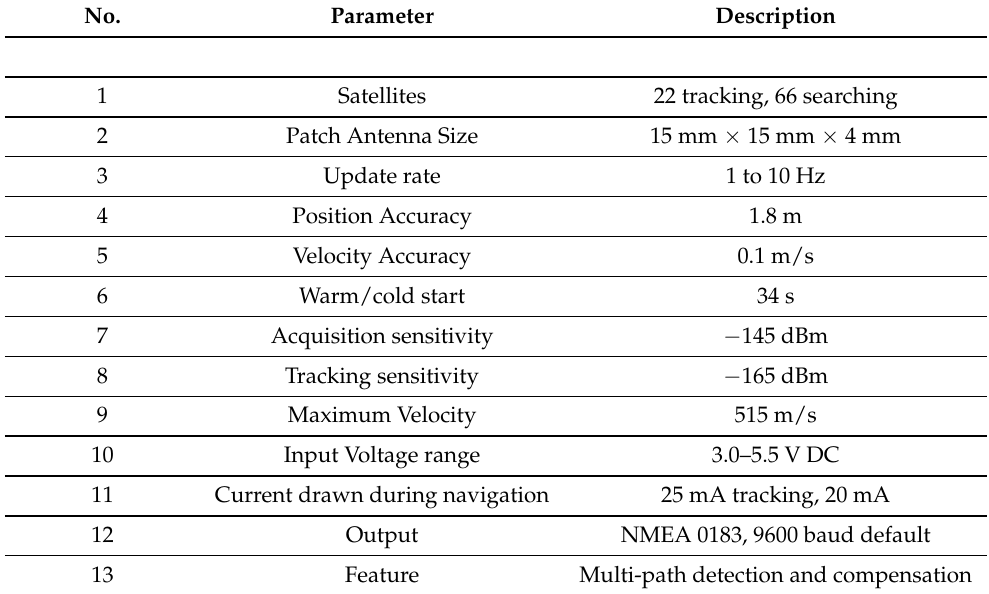
Table 2. Description of main